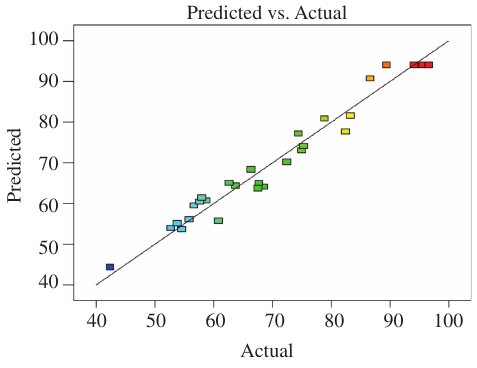
Figure 6 The predicted biodiesel yield versus actual yield.